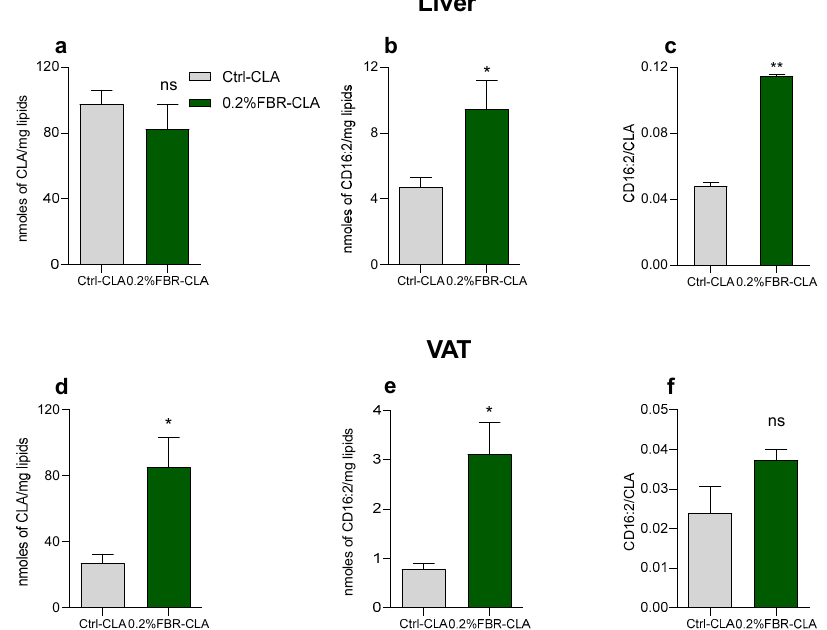
Figure 3. Hepatic levels of ( a ) CLA (CD18:2), ( b ) CD16:2 and ( c ) CD16:2/CLA ratio; visceral adipose tissue (VAT) levels of ( d ) CLA, ( e ) CD16:2 and ( f ) CD16:2/CLA ratio of mice fed a control diet (Ctrl‑ CLA) or a 0.2% fenofibrate‑supplemented diet (0.2% FBR‑CLA) treated with a single dose of CLA (90 µ g/10 g of body weight by oral gavage). Data are expressed as nmoles/mg of lipids and represent the mean ± SEM of n = 5. * p ≤ 0.05, ** p ≤ 0.01; ns = not significant.